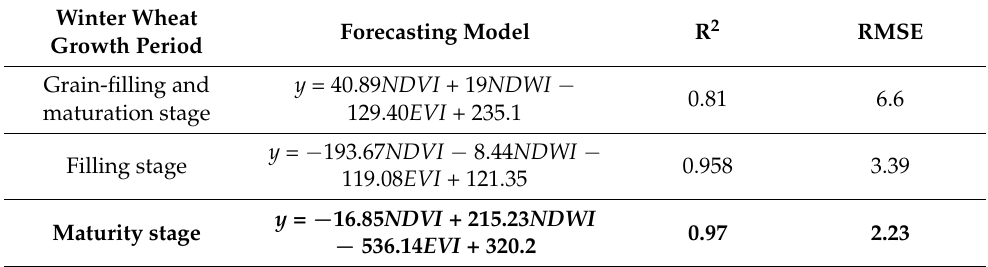
Table 6. Forecasting model of the filling and ripening stage of winter wheat in Henan province.